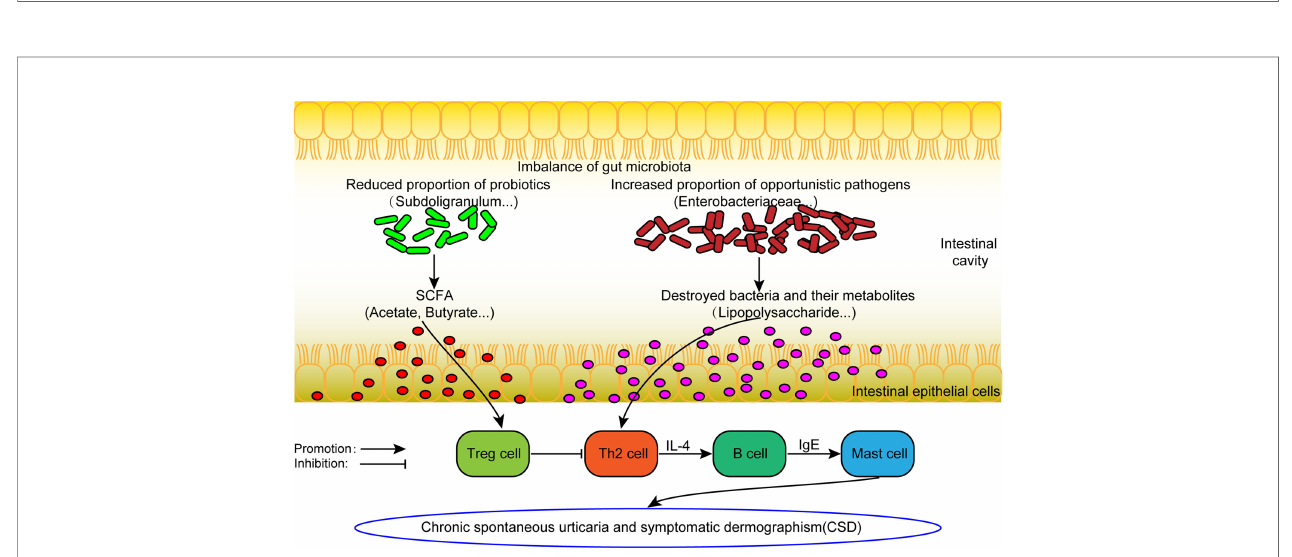
FIGURE 5 | Comparison of short chain fatty acid producing bacteria between the CSD group and NC group. (A) Differential short chain fatty acid producing bacteria in core microbiota between the CSD group and NC group. (B, C) Differential short chain fatty acid producing bacteria that are further con fi rmed by qPCR. NC, normal control; CSD, chronic spontaneous urticaria and symptomatic dermographism. The numbers in the bar on the right of the heat map represent the number of OTUs. *p < 0.05, **p < 0.01, ****p < 0.0001.